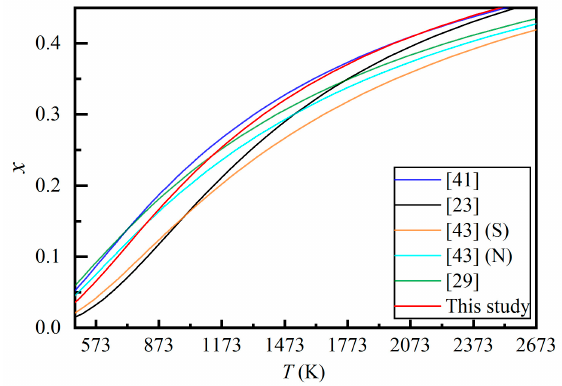
Figure Figure 6. O’Neill and Navrotsky thermodynamic model [50] calibrated by different studies. Two samples, sample S and sample N, were investigated by Redfern et al. [43].